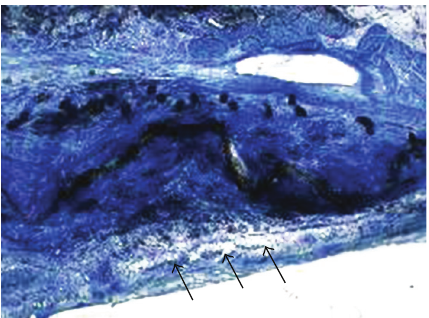
Figure 4: The central pin represents the right atrial hub without signs of corrosion.